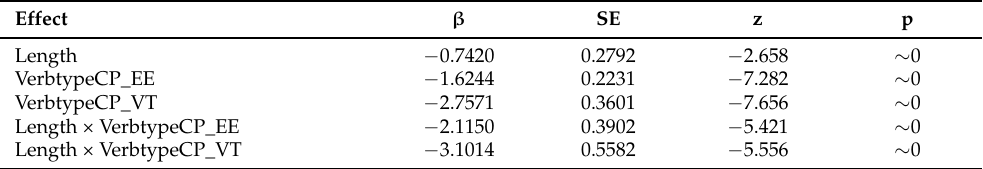
Table A20. Coefficient estimates for Experiment 3 mixed-effects model.